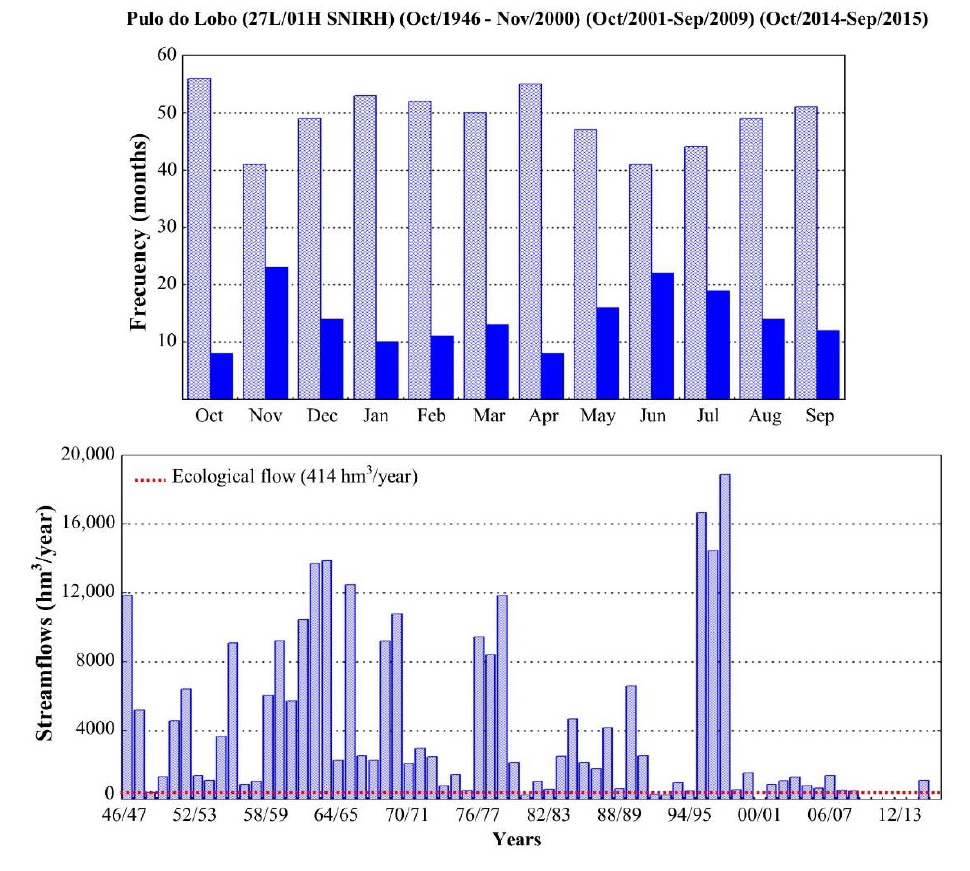
Figure 5. Frequency analysis of the months in which the streamflows were higher (light blue) or lower (dark blue) than the ecological flows requirements identified by the Hydrological Plan of the Guadiana Hydrographic Demarcation (Table 6) and time series of annual streamflows at the gauging station ‘Pulo do Lobo’ (27L/01H SNIRH; main course of the Lower Guadiana River; no available data for hydrological years 2000/01 and from 2009/10 to 2013/14) [17].